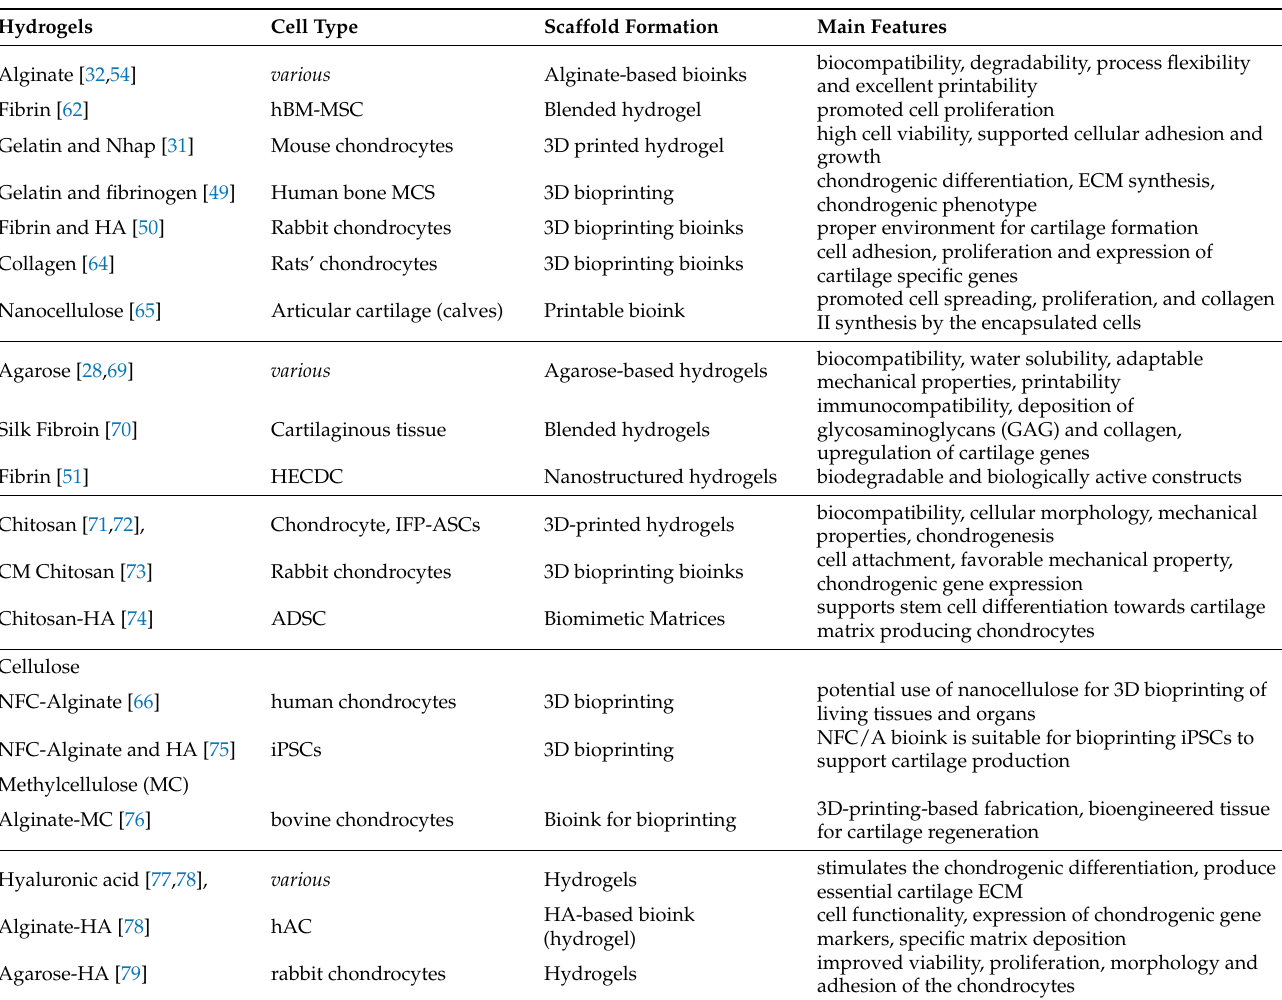
elastic cartilage-derived chondrocytes, ADSC—adipose-derived stem cells, CM—carboxymethyl, IPFP-ASCs—infrapatel- lar fat pad adipose stem cells, iPSCs—human-derived induced pluripotent stem cells, hAC—human articular cartilage.